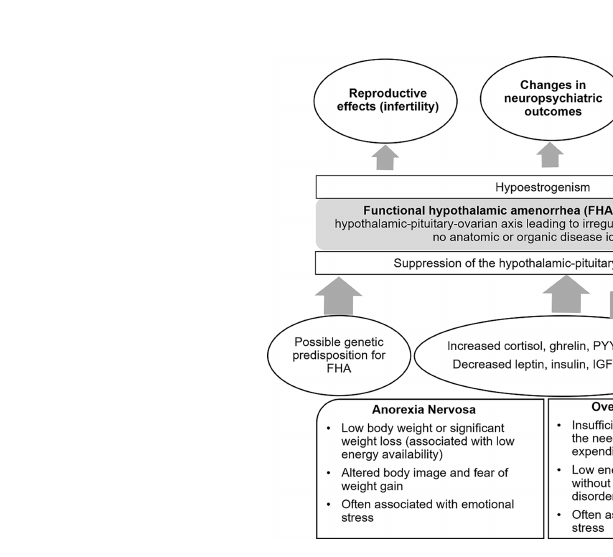
FIGURE 4 Anorexia Nervosa and the Female Athlete